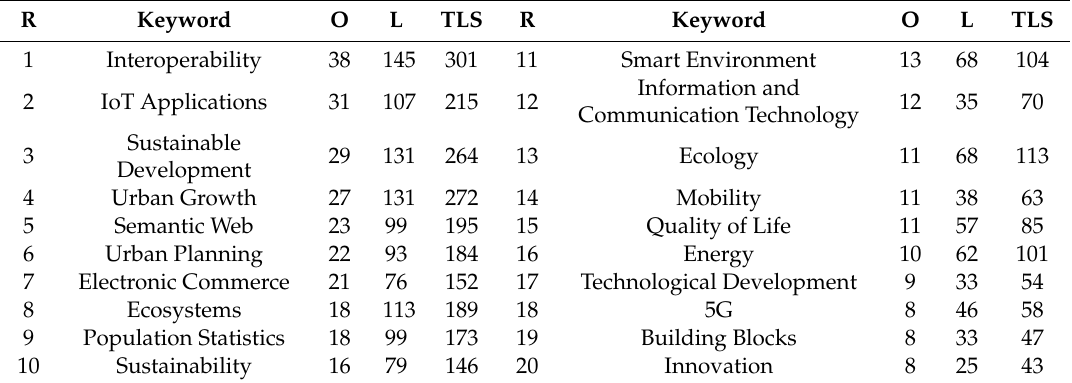
Table 8. Cluster 5: Top 20 keywords